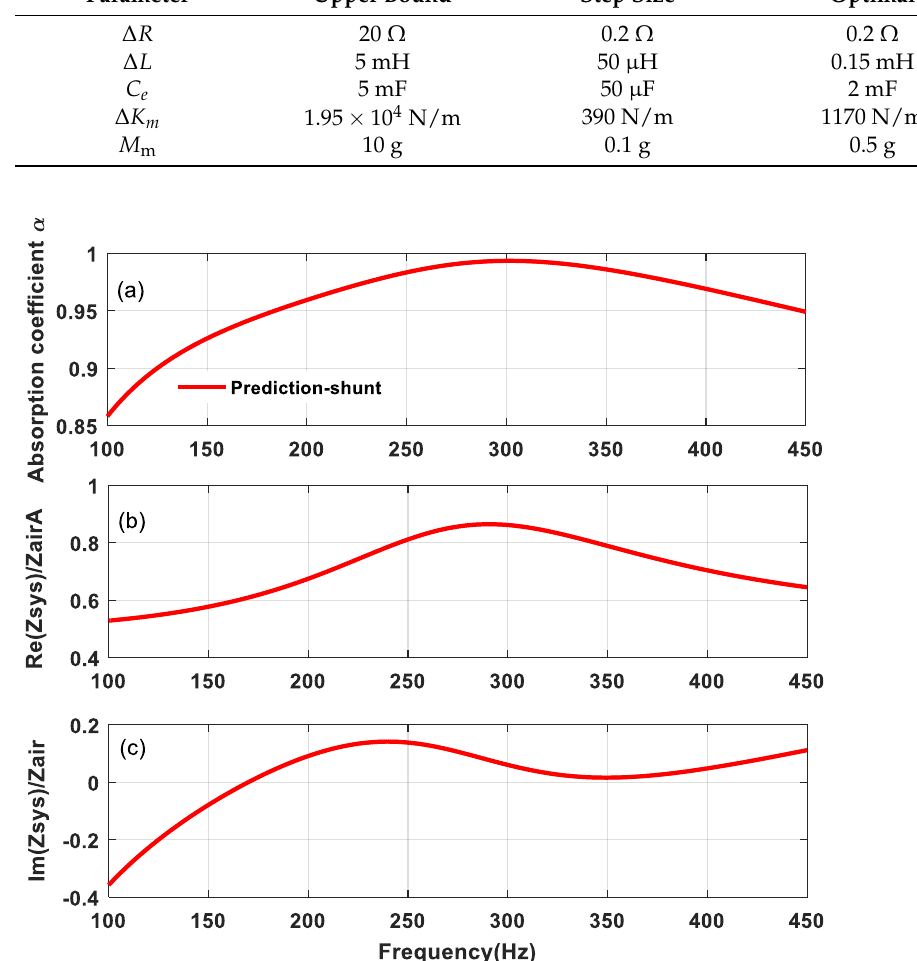
Figure 3. Optimized sound absorption of the SL by a five–dimensional EBA, ( a ) the sound absorption coefficient, ( b ) the specific acoustic resistance, ( c ) the specific acoustic reactance. Table 3. Parameter upper bounds and step size settings.